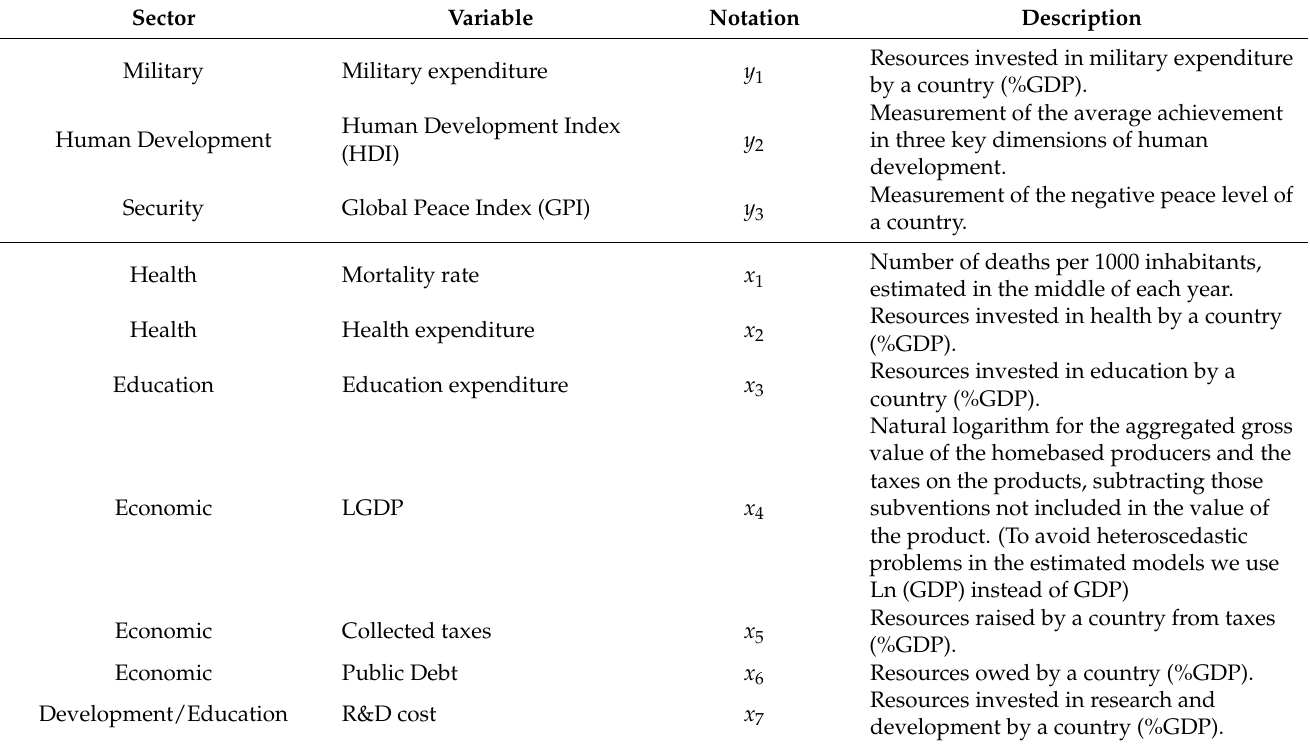
Table 1. Decision variables of the